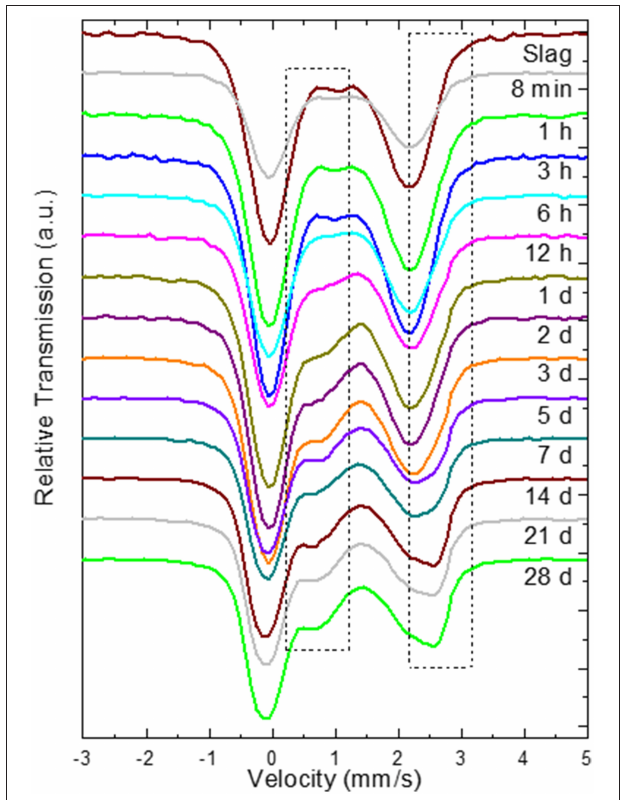
FIGURE 2 | Raw 57 Fe Mössbauer spectra during the first 28 days of reaction, where the numbers indicate the reaction time after mixing, in minutes (min), hours (h), or days (d). The dashed rectangles indicate the regions where the high velocity parts of the new Fe 3 + and Fe 2 + QS doublet contributions of the binder gradually appear.